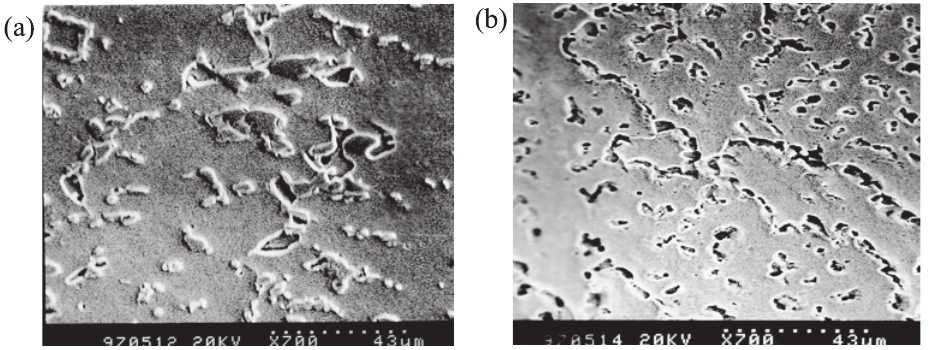
Fig. 14: (a) Grain boundary creep voids near inner surface in base material (SEM, ×700) and (b) grain boundary creep voids and microcracks in weldment (SEM, ×700) [31].